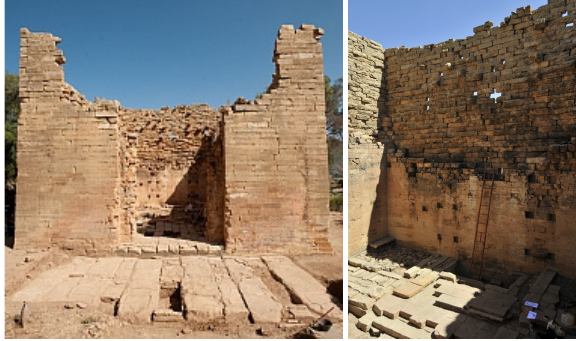
Figure 1: The Almaqah Temple of Yeha, Ethiopia, view from west (left), eastern façade inside the Temple